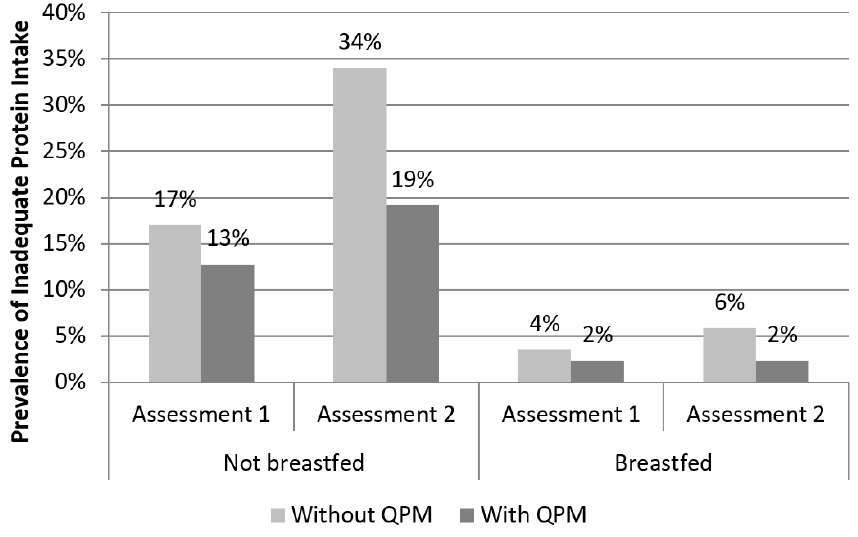
Figure 2. Prevalence of inadequate protein intake with and without quality protein maize (QPM) substitution, disaggregated by child breastfeeding status.